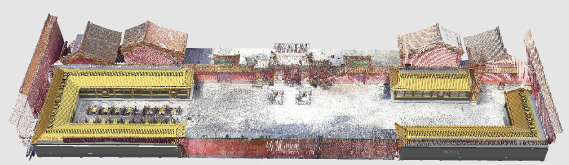
Figure 2 Bird-eye view of the three Duty Rooms (in front, with yellow roofs), mixture of BIM models and point cloud. On the left, upper right and lower right are West, Northeast and Southeast Duty Rooms